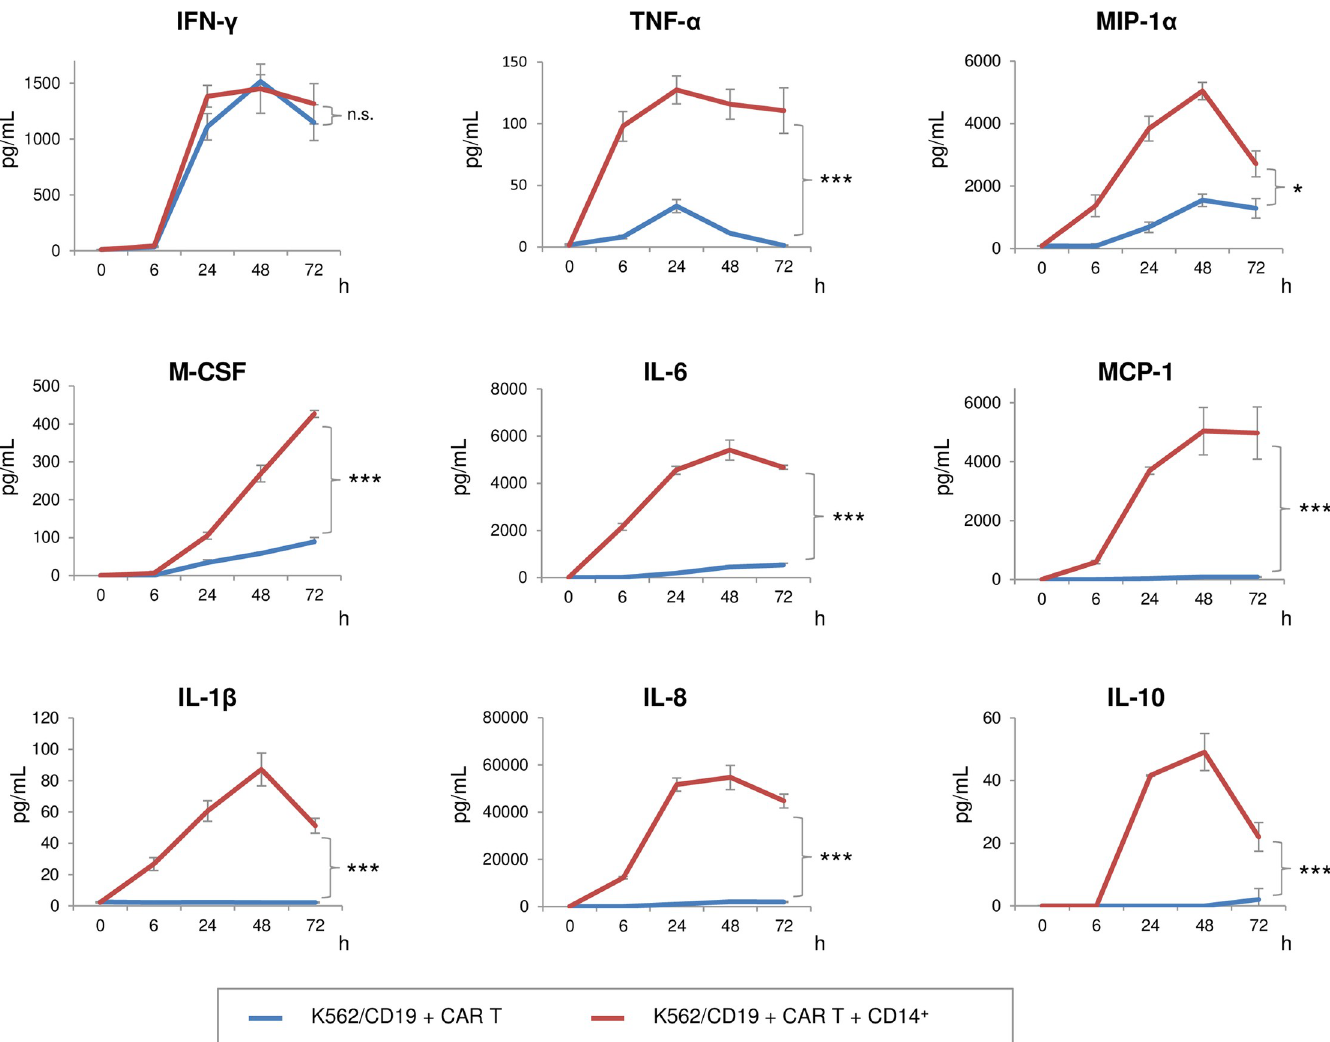
Fig 2. CRS-related, pro-inflammatory cytokine production was dependent on CD14 + monocytes. Time course of cytokine production. Supernatants in the absence (blue line) or presence (red line) of CD14 + PBMCs were recovered, and cytokines were quantitated using a cytokine bead array. The error bars represent SDs from three independent experiments. Difference in time-dependent changes between two groups were assessed using a two-factor linear mixed-effect model with interaction terms, in which the time variable was entered as a categorical variable because the correlation with the outcome was not linear. P < 0.05 was considered statistically significant ( � p < 0.05, �� p < 0.01. ��� p < 0.001). n.s.: not